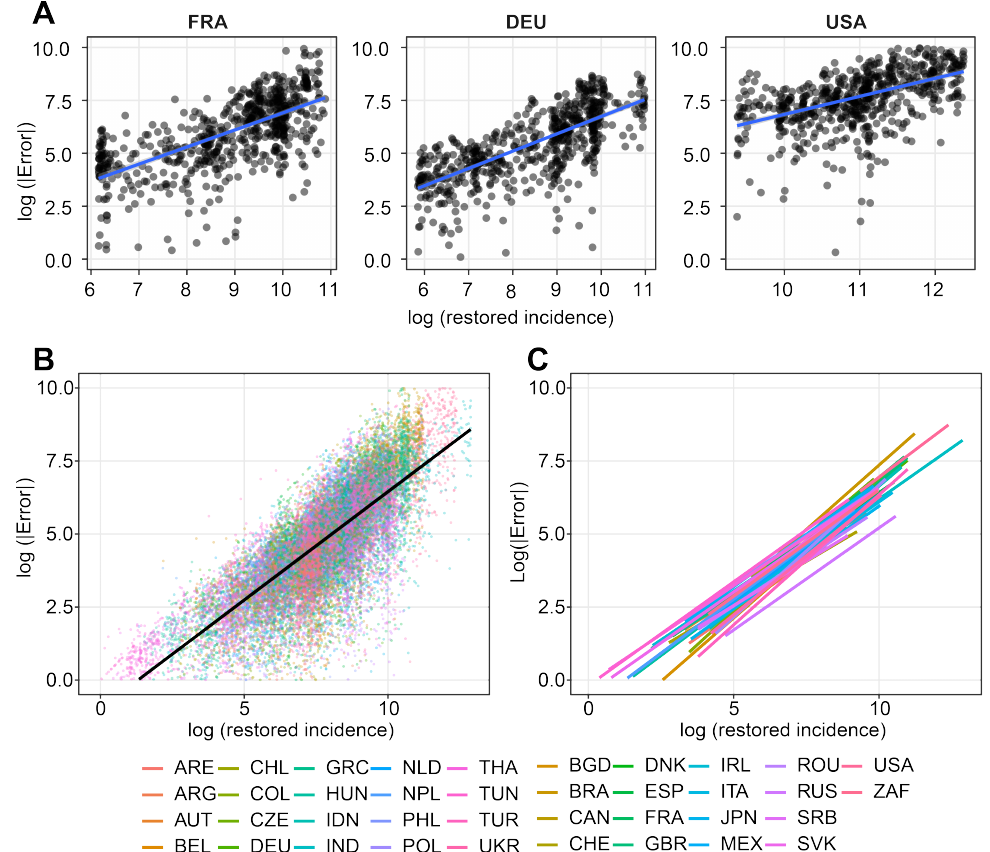
| and the residual | ˆ i t − i r t t